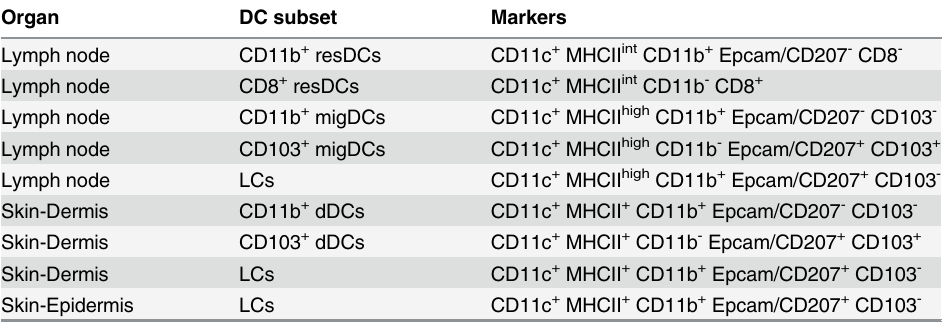
Table 1. DC subsets analyzed in lymph nodes and skin and their identification by surface maker stainings.